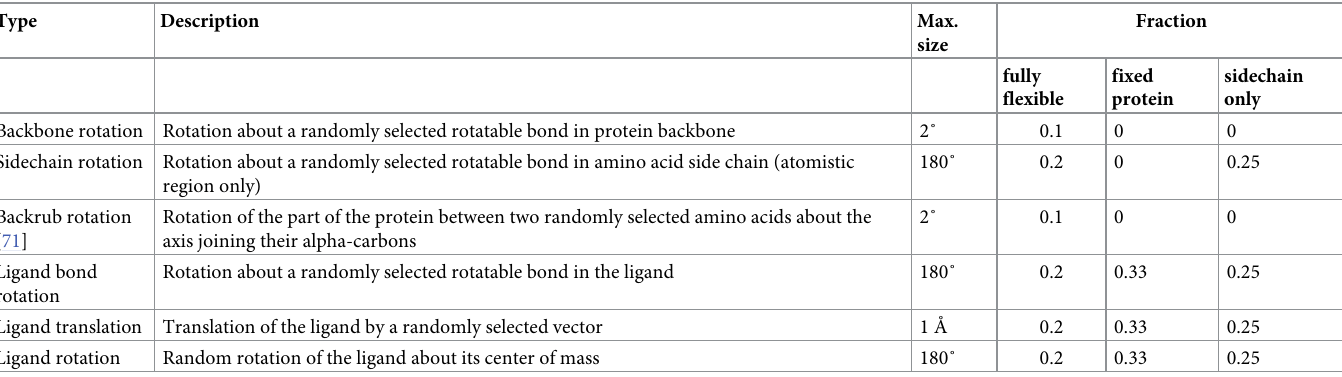
Table 2. Monte Carlo moves used in the